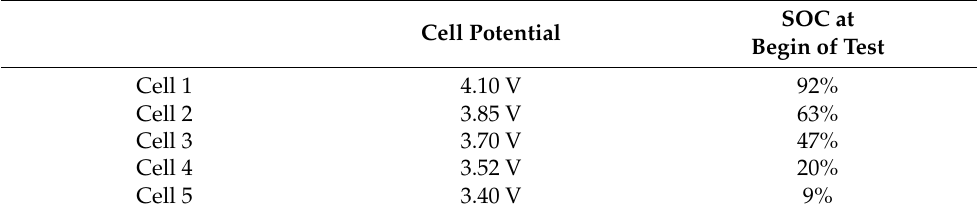
Table 3. Test matrix.